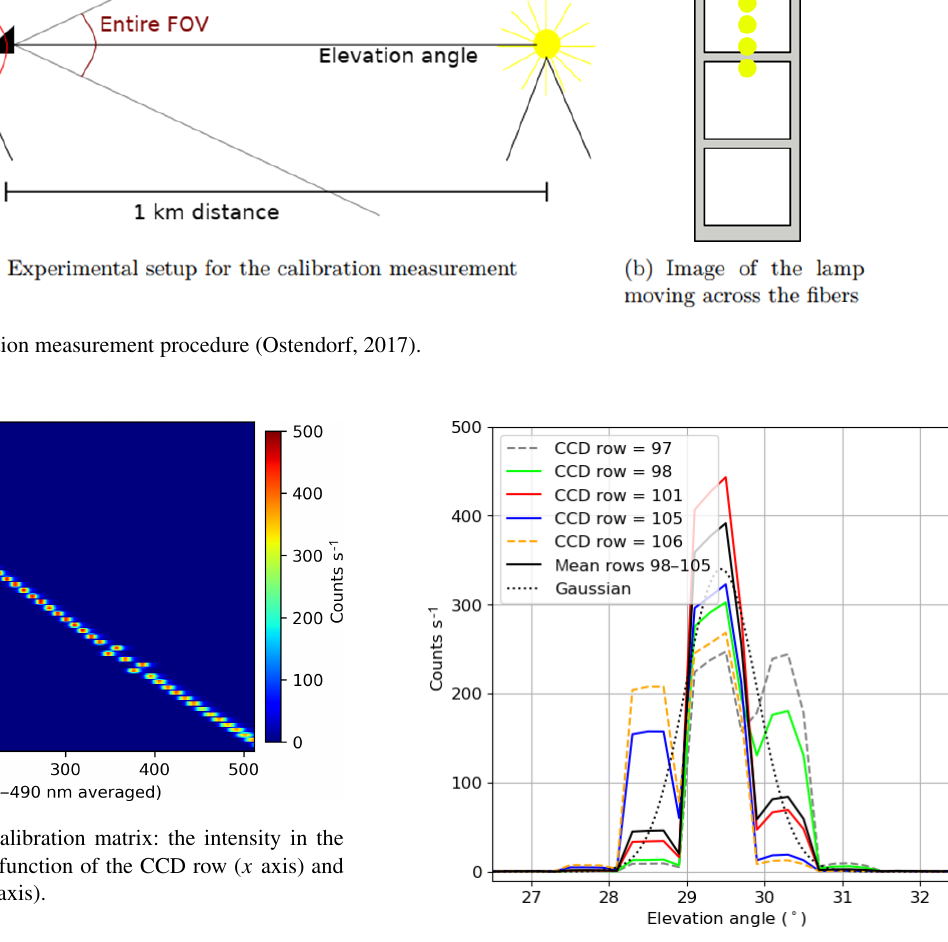
Figure 5. Cross sections through the calibration matrix. The defined binning range comprises rows 98–105 which all show a clear maxi- mum in the same fiber, most pronounced in row 101. CCD rows 97 and 106 are rejected as their intensity distribution cannot be clearly assigned to one fiber. The mean of the binning range is plotted in black together with the corresponding Gaussian curve (same stan- dard deviation) in order to estimate the effective